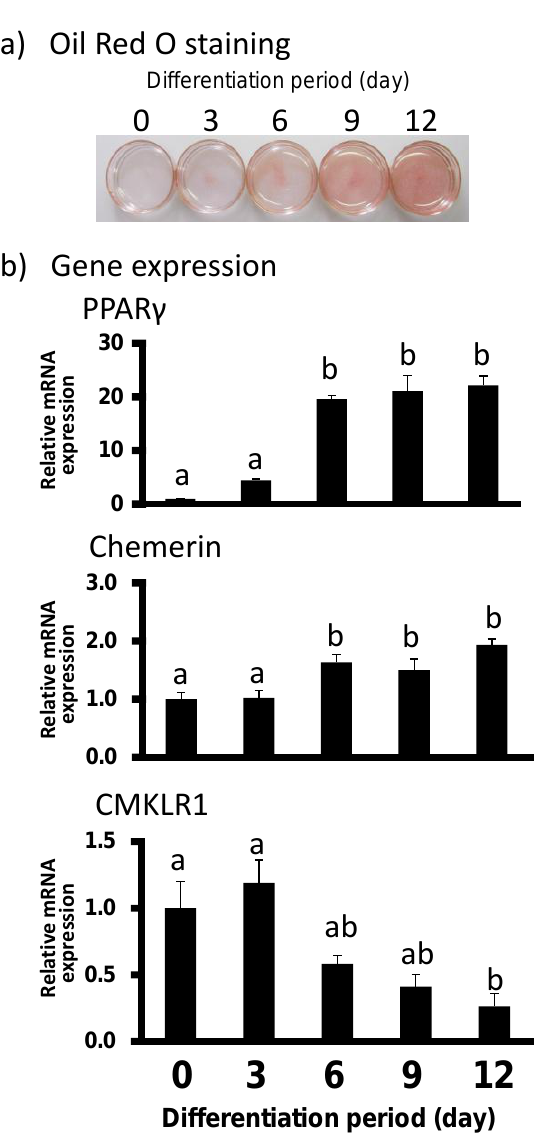
Figure 1. Lipid accumulation and gene expression levels of PPAR-  2, chemerin and CMKLR1 mRNA during bovine adipocyte differentiation. (a) Oil Red O staining of bovine differentiated adipocytes at indicated days of differentiation. (b) Gene expression level of PPAR-  2, chemerin and CMKLR1 when Oil Red O staining was performed. The data for expression analysis are shown as means  SEM and collected from at least three experiments. The data were normalized with 18s rRNA and expressed in relative to the expression levels of day 0. a,b Values marked with different letters within each gene differ significantly